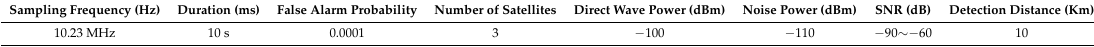
Table 7. Parameter setting of experiment 4.